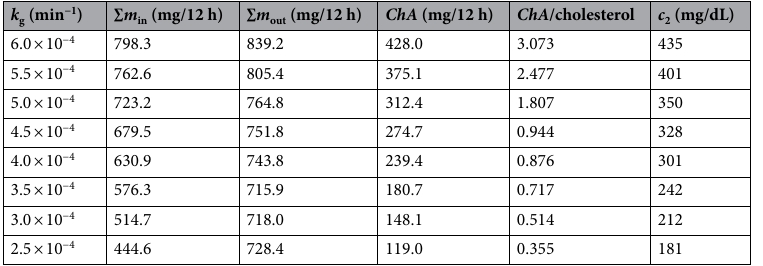
Table 2. Effect of gall bladder filling rate on the amount of cholesterol transported with bile, the amount of ChA synthesized during 12 h, the ratio of de novo-synthesized ChA to cholesterol, and total cholesterol in the blood